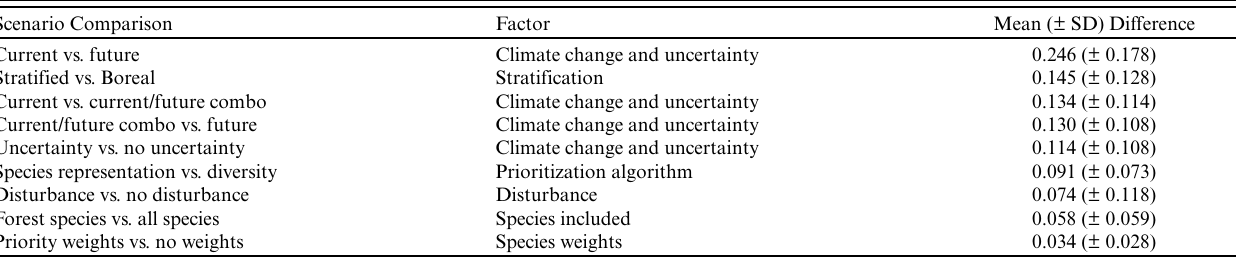
Table 3 . Overall scenario factor influence on conservation value. Pairs of scenarios were evaluated by calculating the pixel-level differences in mean priority ranks across all other scenario factors. Values represent mean and standard deviation of pixel-level differences in priority ranks ranging from 0 to 1.